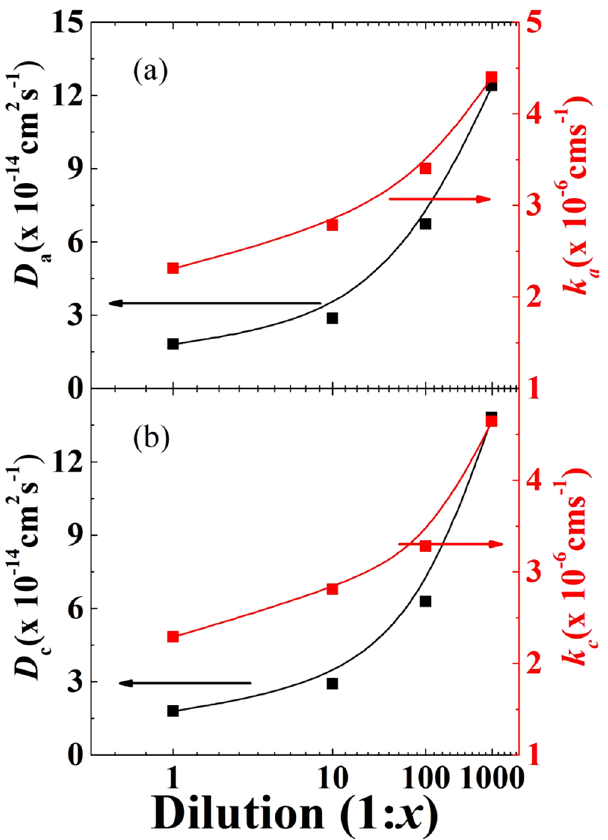
Figure 5. ( a , b ) Variation in diffusion coefficient D a , D c and charge transfer rates k a , k c for various dilutions of COx-MAA-QDs modified GC electrode as determined from CV